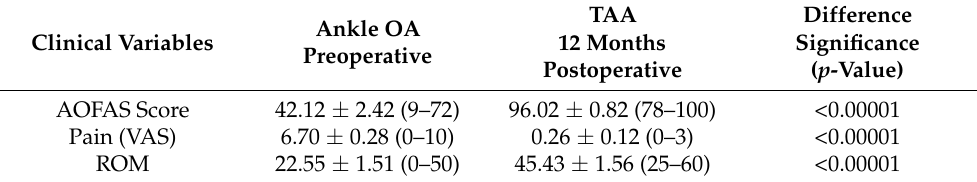
Table 2. Clinical Results.